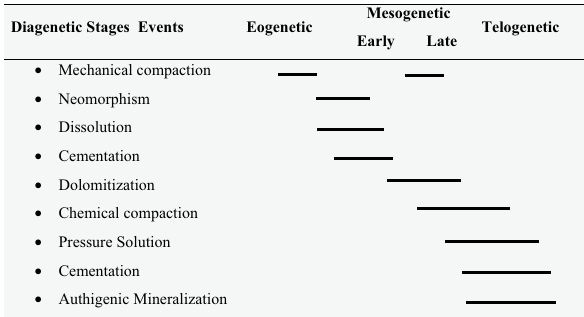
X.N., c Solution enlarged fracture with Radiolarian mold, Br-38, X.N., d Framboidal pyrite in micritic matrix, possibly indicating anoxic (Reducing) environment of deposition, Br-39, P.P